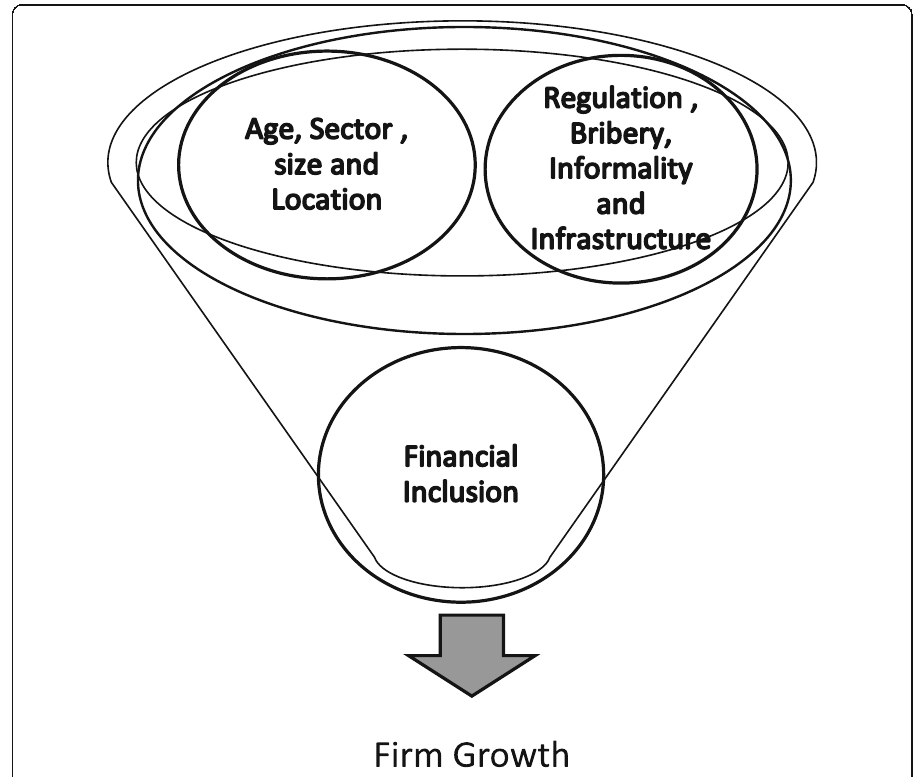
Fig. 1 Factors affecting firm growth. Source: